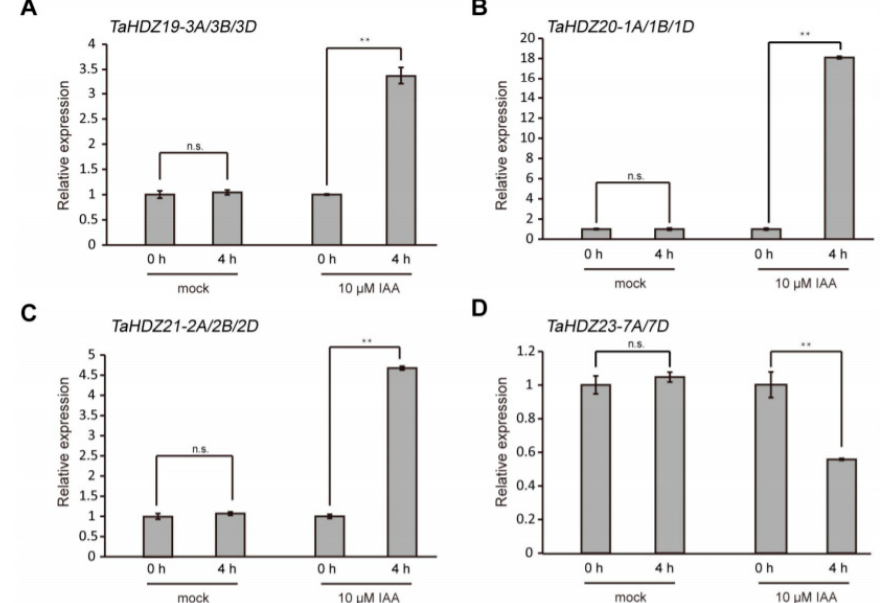
Figure 9. Several wheat HD-ZIP II subfamily genes were regulated by auxin. ( A–D ) Auxin-induced expression pattern of TaHDZ19-3A / 3B / 3D, TaHDZ20-1A / 1B / 1D, TaHDZ21-2A / 2B / 2D and TaHDZ23-7A /